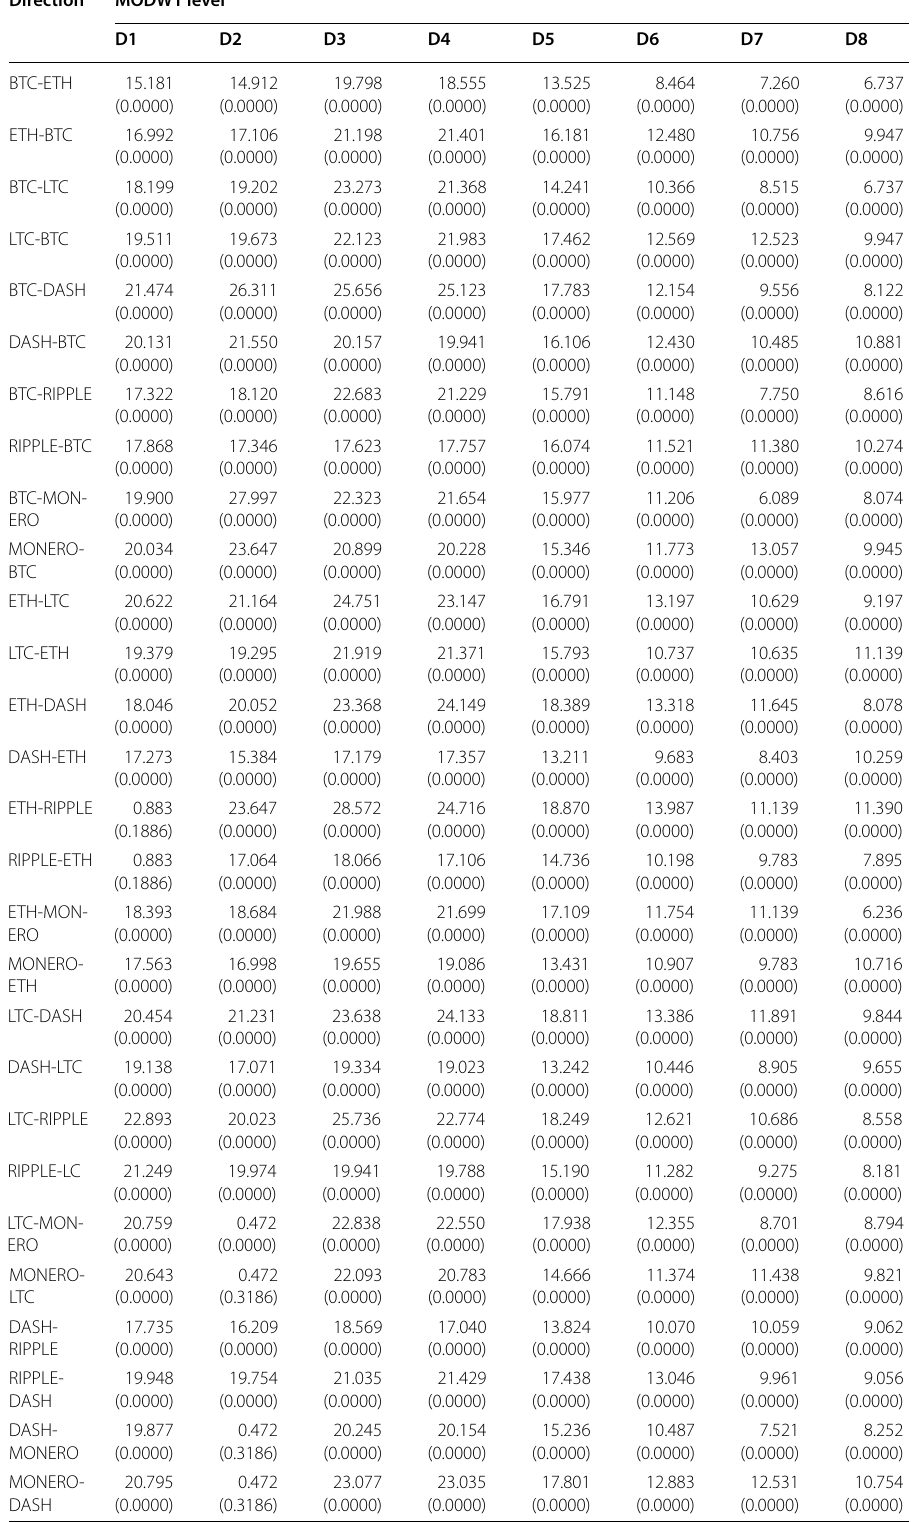
Table 4 Estimates for non‑linear Granger causality at decomposed levels